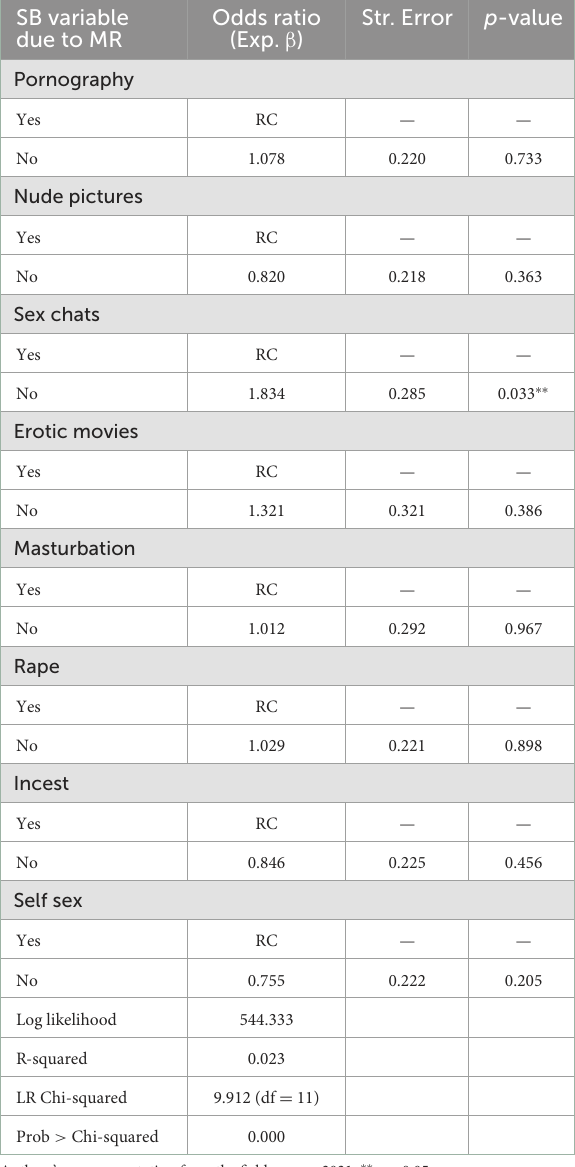
TABLE 4 Logistics regression estimating the odds of unhealthy SBs instigated by MR. SB variable due to